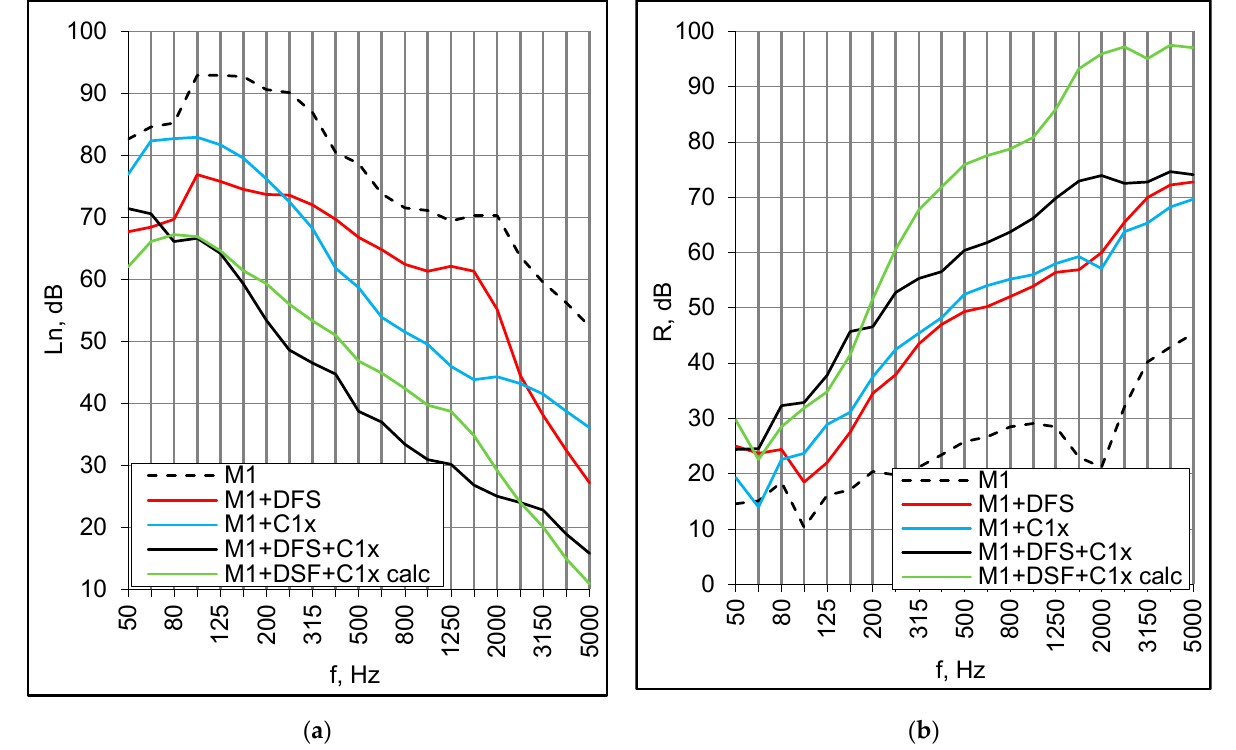
Figure 14. ( a ) Impact sound insulation: M1 panel with a dry floating screed (DFS) and suspended ceilings C1x. Measured and calculated (calc) values; ( b ) Airborne sound insulation: M1 panel with a dry floating screed (DFS) and suspended ceilings C1x. Measured and calculated (calc) values. Table 5. Single number values for the M1 panel with a dry floating screed (DFS) and a suspended